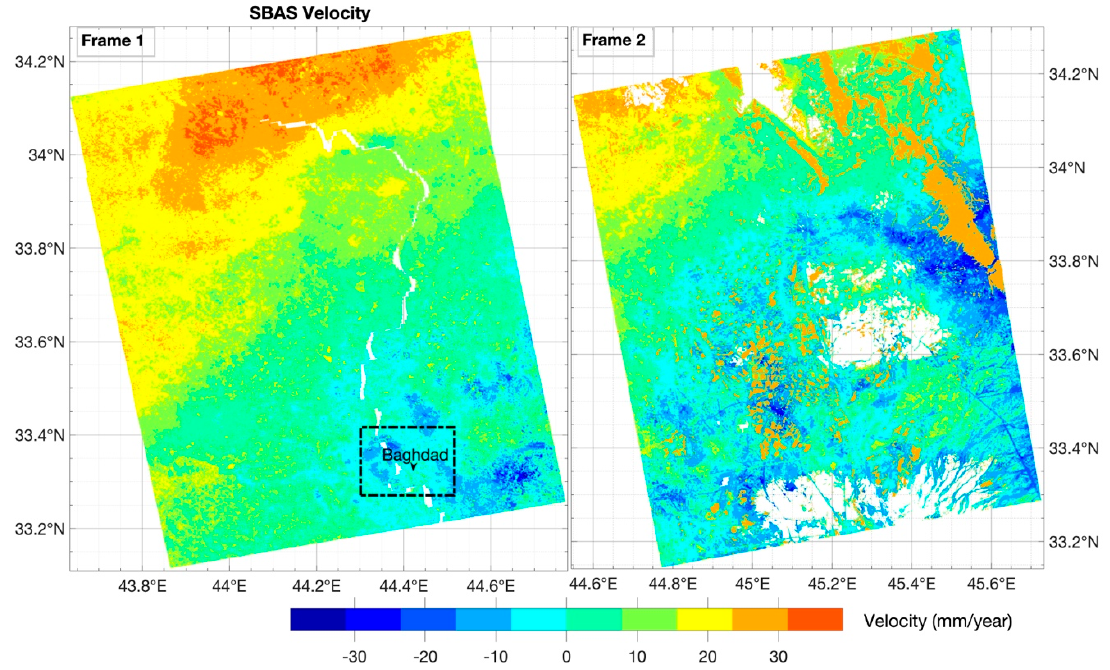
Figure 5. Cumulative vertical displacements between 2015 to 2018 in the central part of the Tigris–Euphrates basin (TEB).